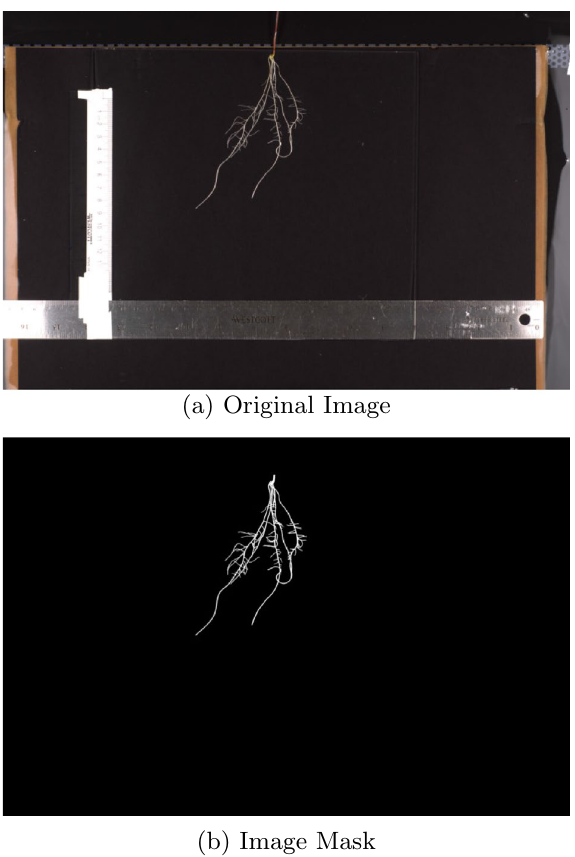
Figure 5. Example image ( a ) with its human annotated ground truth mask ( b